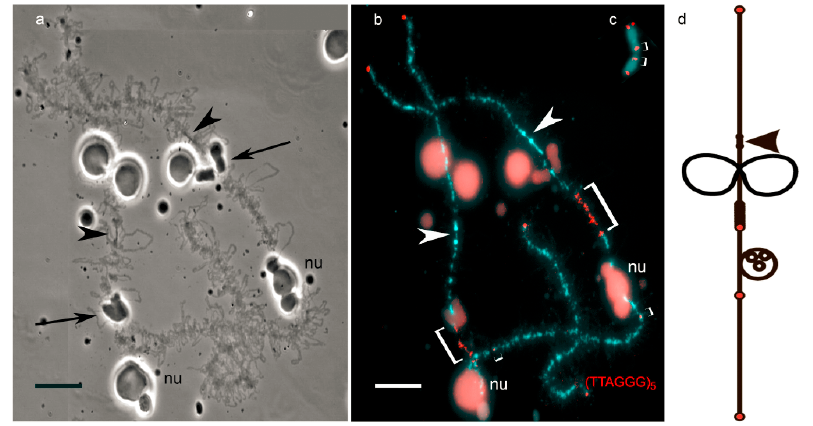
Figure 1. Comparison of the usage of amphibian lampbrush chromosome ( a , b ) and metaphase chromosome ( c ), for high-resolution fluorescent in situ hybridization (FISH)-mapping. Lampbrush chromosomes exhibit marker loops (indicated by arrows in ( a )) and other landmarks (including nucleolus, nu in ( a , b )), which allows to construct cytological chromosomal maps ( d ). Such maps